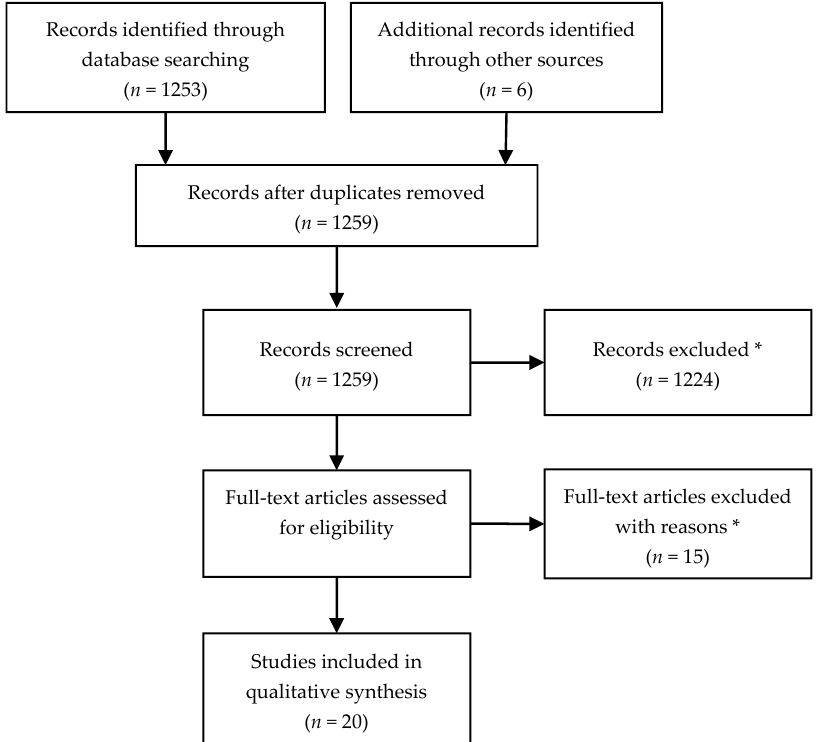
Figure 3. Preferred Reporting Items for Systematic Reviews and Meta-Analyses (PRISMA) flow diagram for study inclusion. * Exclusion criteria is detailed within the methods.